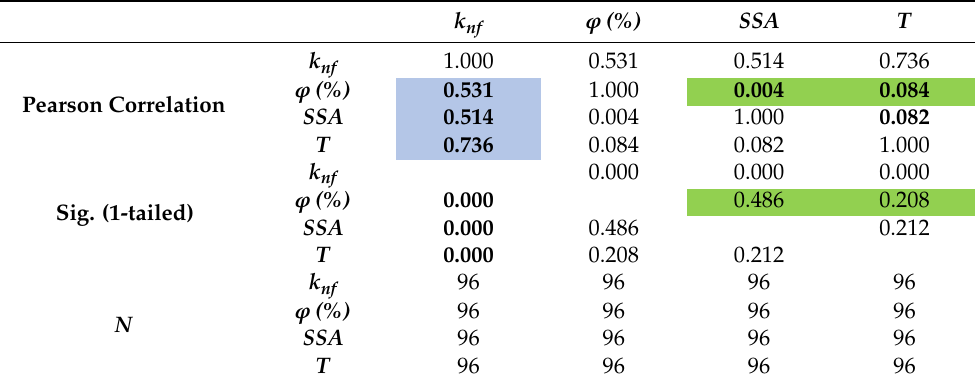
Table 2. Associations between the dependent and independent